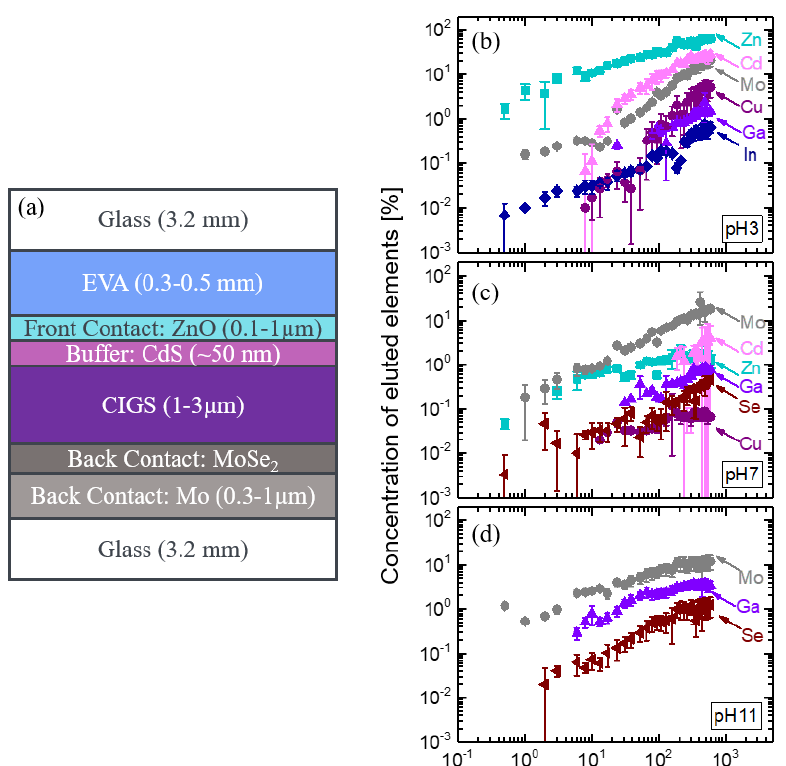
Figure 8. ( a ) Schematic structure of a typical CIGS module (not drawn to scale) and ( b ) time- dependent leaching results of the elements Zn, Cd, Mo, Cu, Ga, and In from CIGS module pieces in acidic aqueous solutions with pH 3 and ( c ) in solutions with pH 7 and ( d ) pH 11. In leaching solutions with pH 11, the concentrations of the elements Cd, Zn, Cu, and In are below the detection